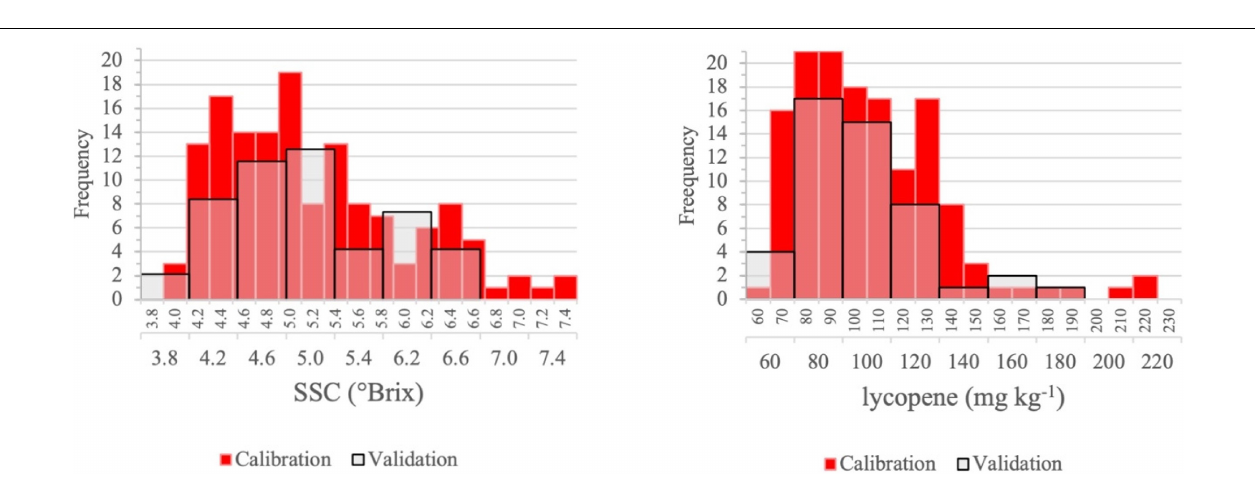
FIGURE 5 | Distribution of SSC and lycopene content of homogenized samples for the calibration ( n = 144) and validation ( n = 48) sets. TABLE 2 | SSC and lycopene content of intact tomato fruits and homogenized samples in the calibration and validation sets. Total ( n = 132) Calibration ( n =